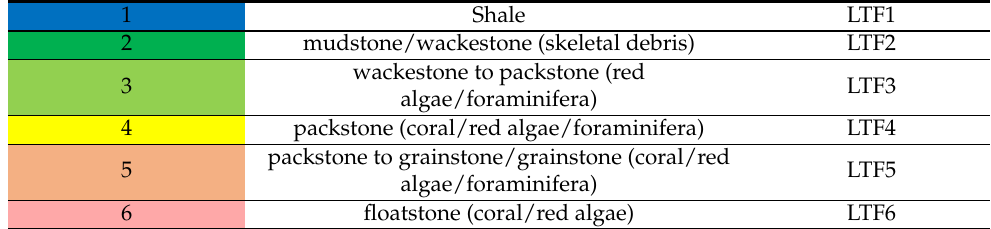
Table 4. List of 6 lithofacies types used for IPSOM map